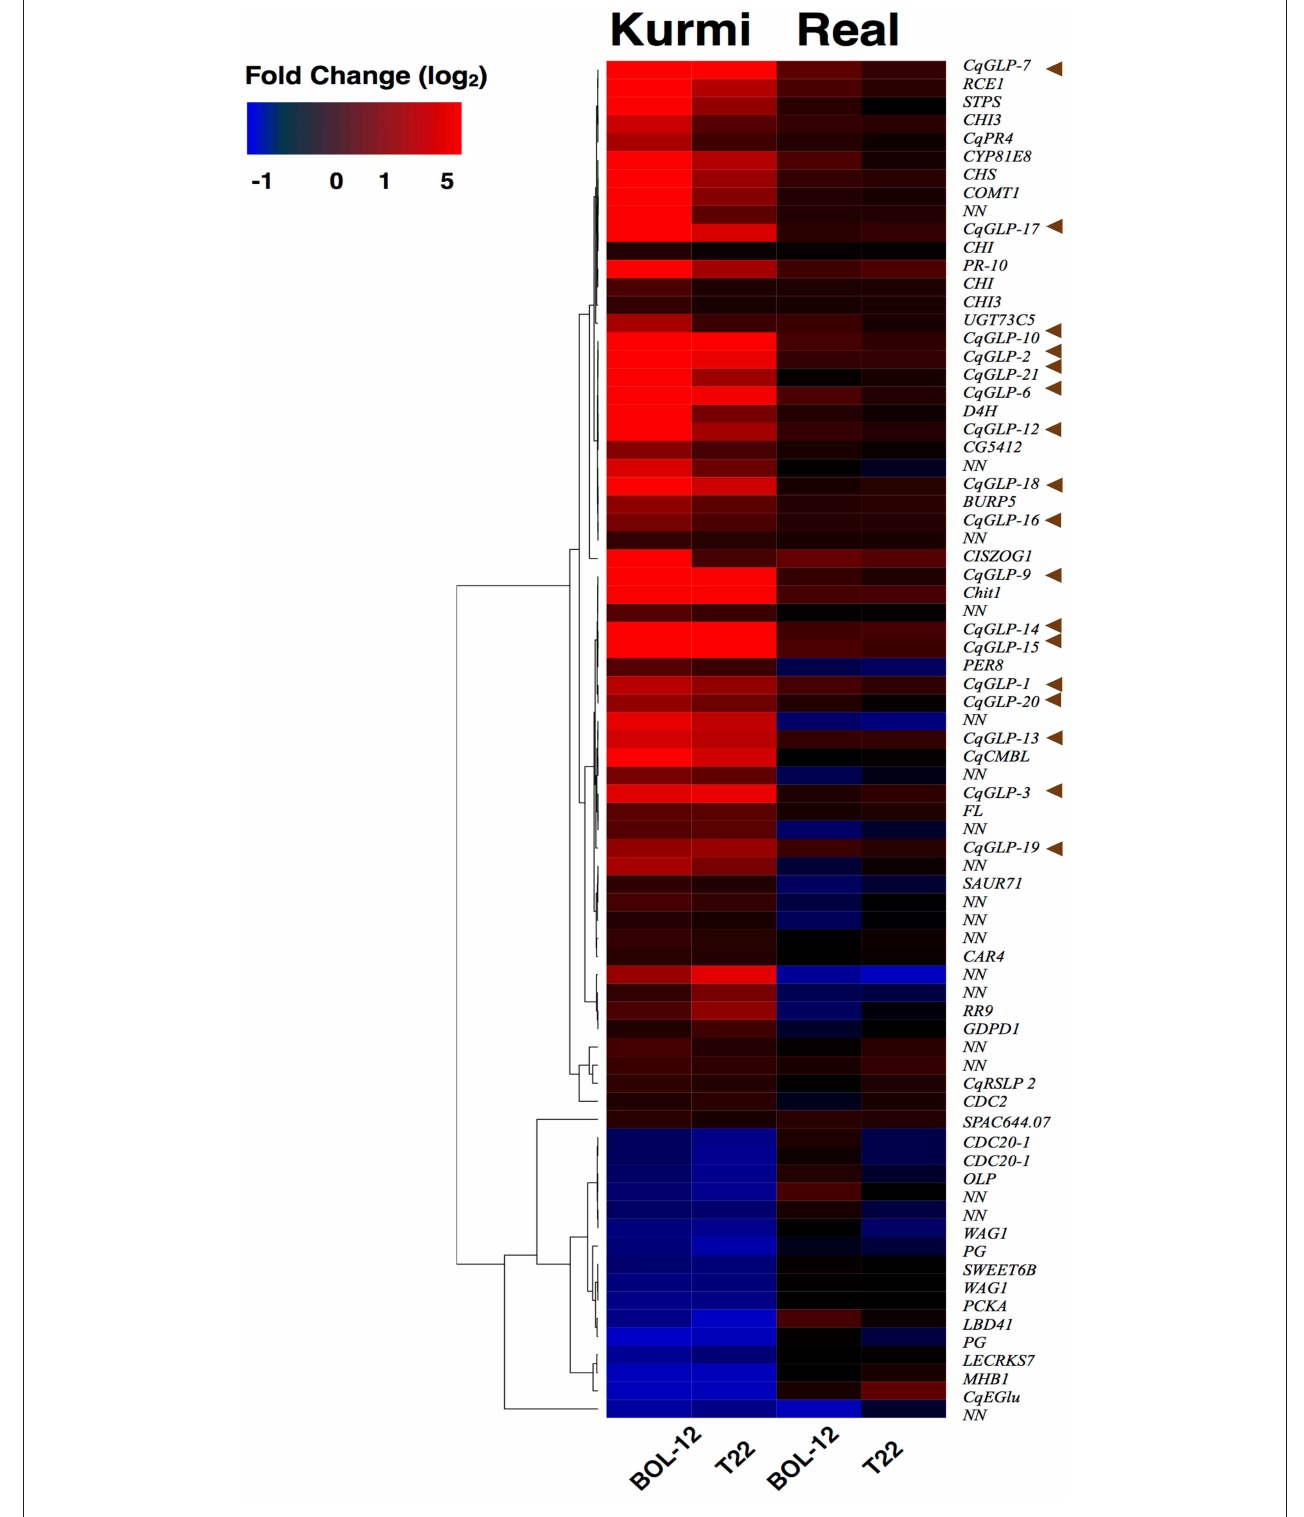
FIGURE 2 | Heatmap profile of genes that respond to to Trichoderma BOL-12 and T22 in cv. Kurmi but not in C. quinoa cv. Real. Genes differentially expressed in cv. Kurmi in response to either Trichoderma strain, but not significantly responsive in cv. Real, were analyzed. Clustering by Euclidean distance shows the similarity in expressional change upon Trichoderma treatment. Brown arrows indicate CqGLPs .